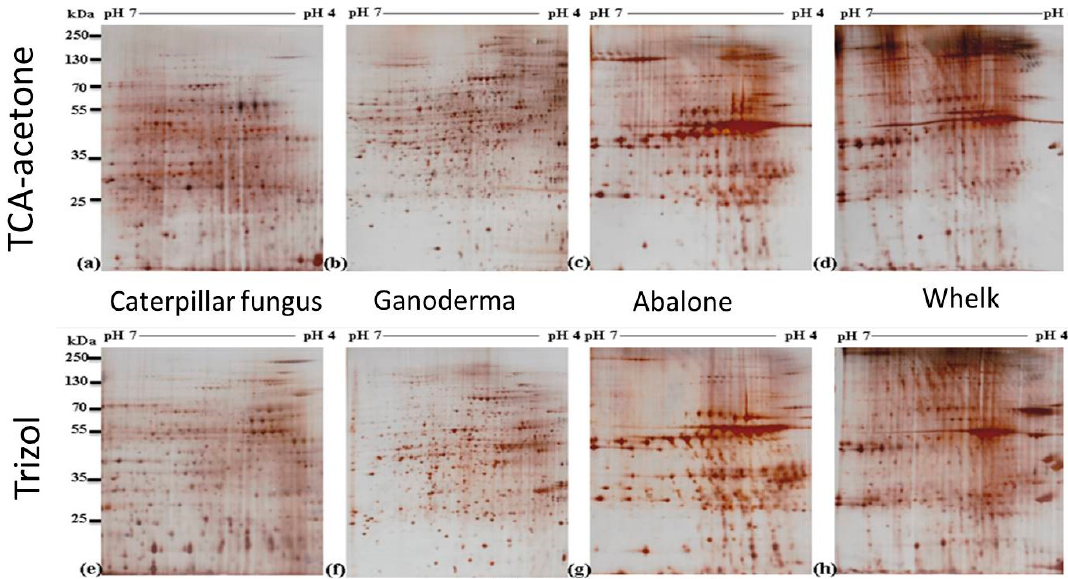
Figure 3. 2-DE gels of total protein extracts (100 μ g) of caterpillar fungus ( a , e ), ganoderma ( b , f ), abalone ( c , g ), and whelk ( d , h ) samples were loaded onto 18 cm immobilised pH gradient (IPG) strip with a pH range of 4–7 using TCA-acetone precipitation method ( a – d ) and Trizol extraction method ( e – h ). The silver staining method was used.